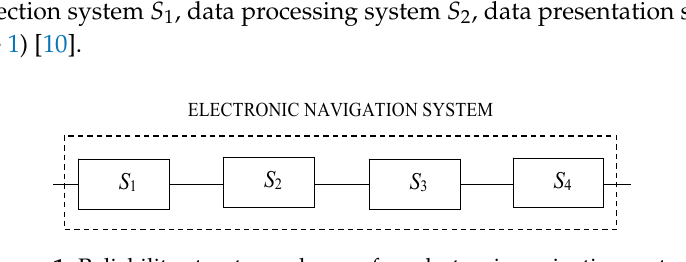
Figure 1. Reliability structure scheme of an electronic navigation system.